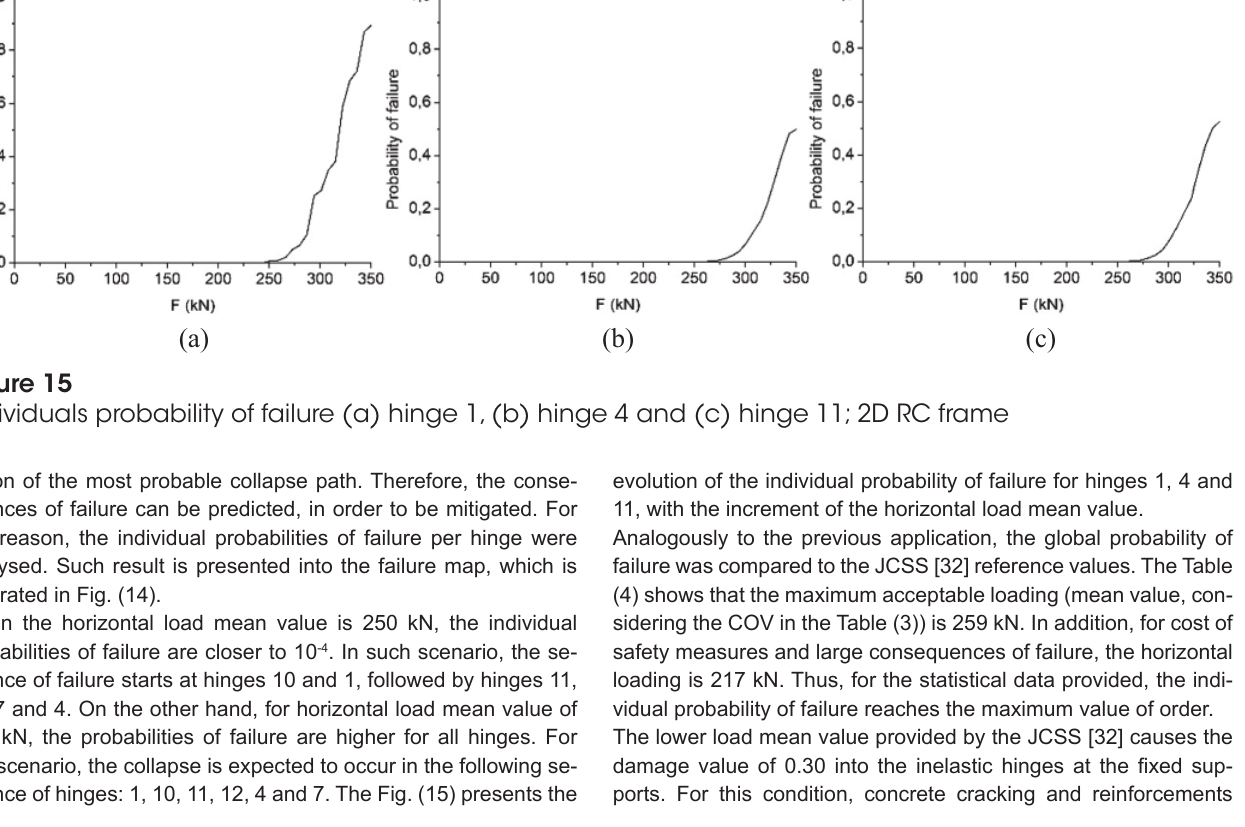
Maximum mean loading (in kN) based on JCSS [32]. 2D RC frame Relative cost of safety